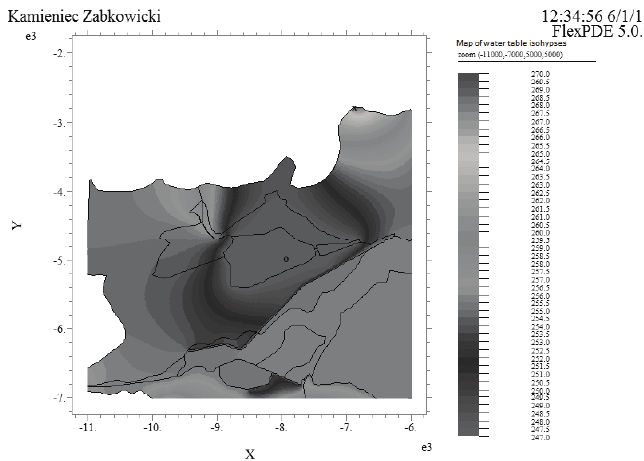
Fig. 11. Map of water table isohypses around Przyłęk